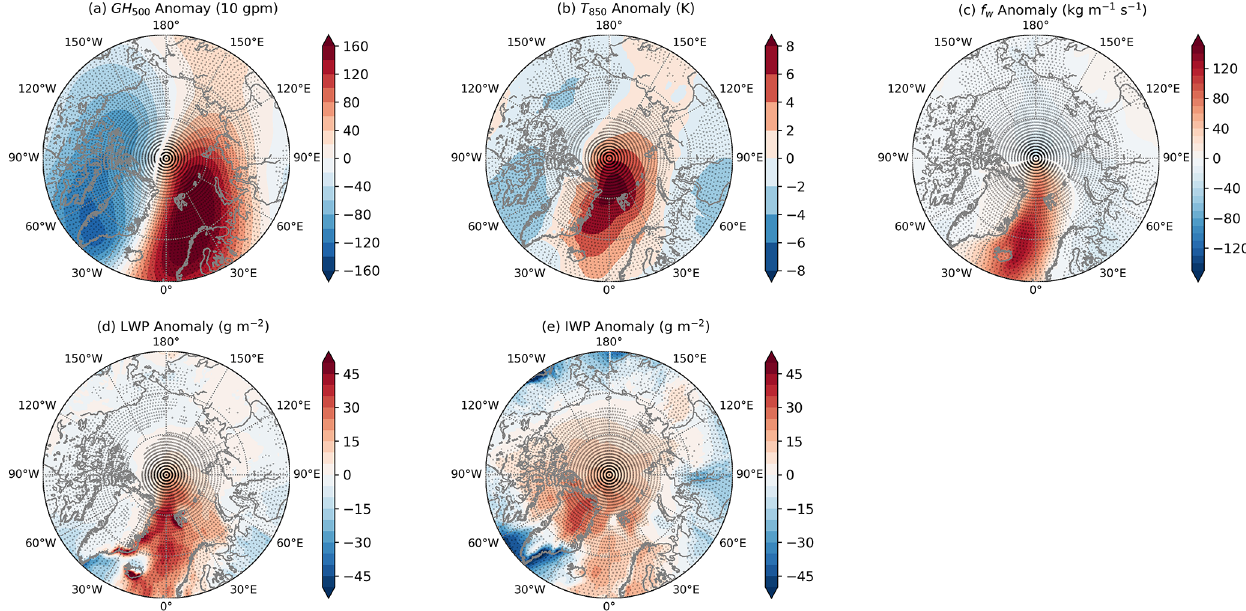
Figure 3. Composite ERA5 anomalies of (a) 500hPa GH (10gpm), (b) 850hPa temperature (K), (c) northward water-vapor flux (kgm − 1 s − 1 ), (d) liquid water path (gm − 2 ), and (e) ice water path for all EMIs over the Barents Sea, during 1979–2018 winters. The stippling indicates statistical significance at the p < 0 . 01 level from a Student’s t test.